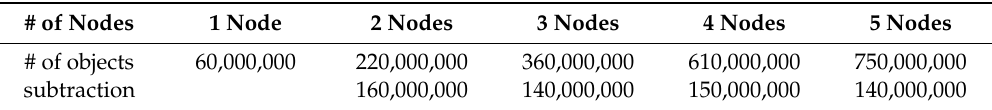
Table 4. Maximum amount of data stored within the timeout.